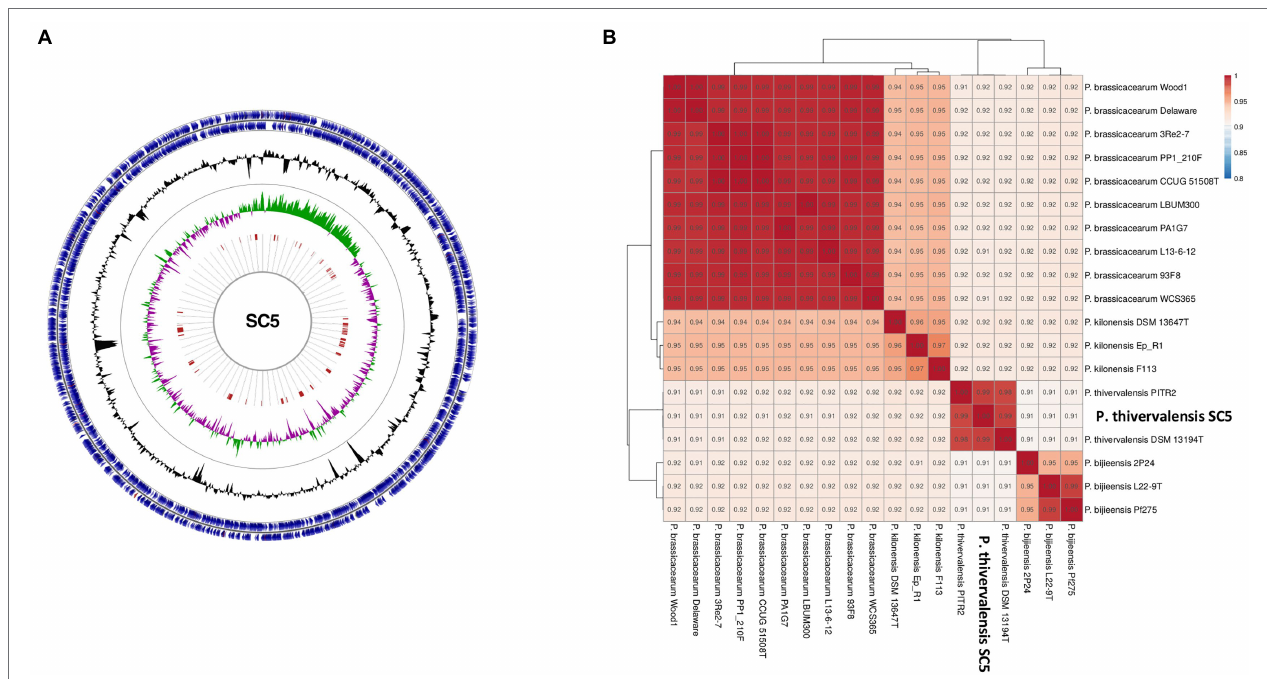
FIGURE 2 | Representation of the P. thivervalensis SC5 genome. (A) Circular representation of the genome and its properties, including genes (blue), GC% (black), GC% skew [(+) green, and ( − ) pink] and genomic islands (red); (B) Phylogenomic analysis based on average nucleotide identity (ANI) values of selected Pseudomonas